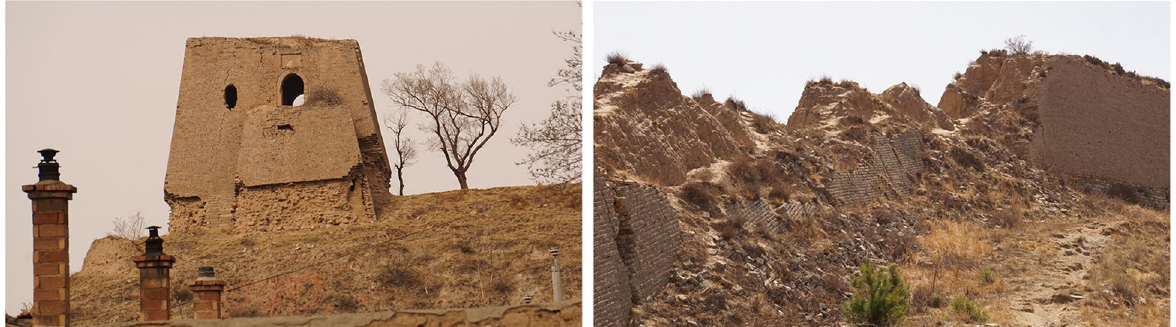
Fig. 3 Typical damage in Shanxi Province. Left: mainly anthropogenic. Right: mainly natural (Source: Tongji-ACL)